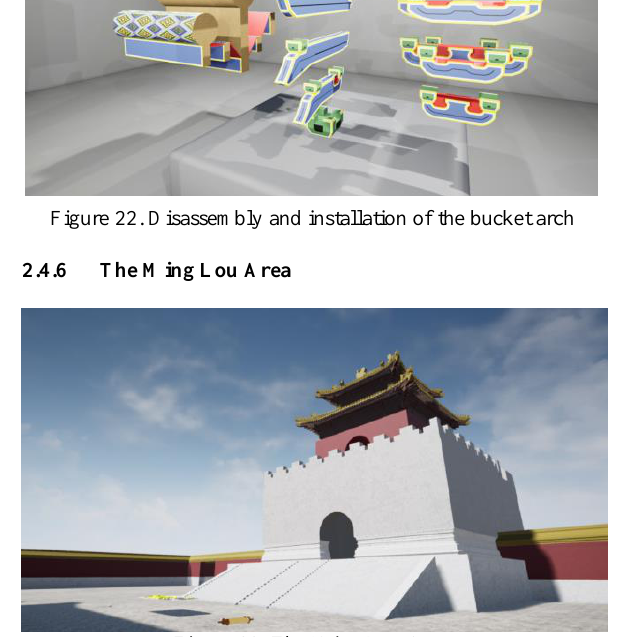
Figure 23. The Ming Lou Area